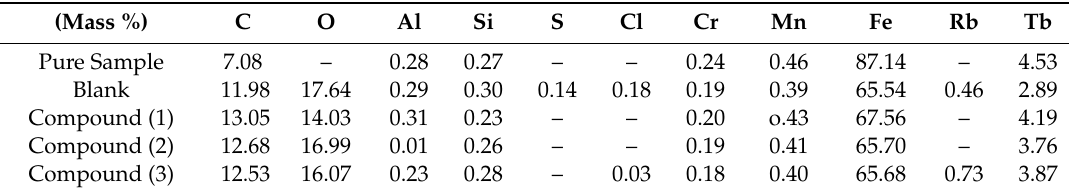
Table 6. Mass % of Q235 steel after 3 days in corrosive environments attendance and lack of unlike dose of 11 × 10 − 6 M spiropyrazoles.